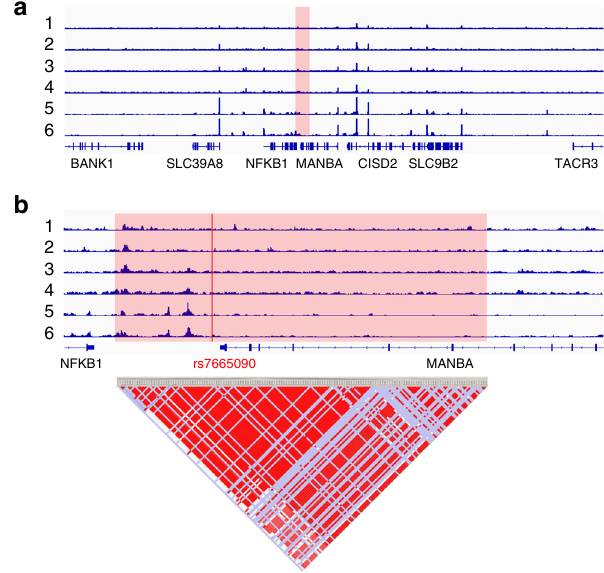
Fig. 1 Chromatin accessibility in the NFKB1 / MANBA risk haplotype block in astrocytes and T cells. The rs7665090 risk variant tags a haplotype block that lies within MANBA and the intergenic space between NFKB1 and MANBA and contains more than 90 variants in tight linkage disequilibrium 32,33 . a Normalized ATAC-seq pro fi les in the NFKB1/MANBA risk locus are similar in unstimulated and stimulated human iPSC-derived astrocytes (1, 2), unstimulated and stimulated human fetal astrocytes (3, 4), and in ex vivo effector and regulatory T cells (5, 6). The height of the bar graph at each point represents the number of unique, singly-mapping reads at each genomic position; each track is normalized for library size. The NFKB1/MANBA haplotype block is shaded in red. The genomic coordinates are chr4:101,796,383 – 103,694,281. b Higher magni fi cation (chr4:102,614,123 – 102,674,492) of the risk haplotype block, shaded in red, shows accessible chromatin, mostly in the intergenic region between NFKB1 and MANBA with comparable ATAC-seq pro fi les in astrocytes and T cells. The location of the tagging SNP rs7665090 is indicated by the red line. Pairwise linkage disequilibrium ( D ′ ) values between SNPs in the CEU population of the 1000 Genomes Project are indicated below (red indicates D ′ > was further con fi rmed by the mutually exclusive chromatin accessibility in lineage-speci fi c genes of astrocytes and T cells (glial fi brillary acidic protein (GFAP), CD2). Thus, our results indicate that while NFKB1 is expressed by a multitude of cell types, accessibility of different regulatory enhancer regions for the NFKB1 gene varies among different cell types.